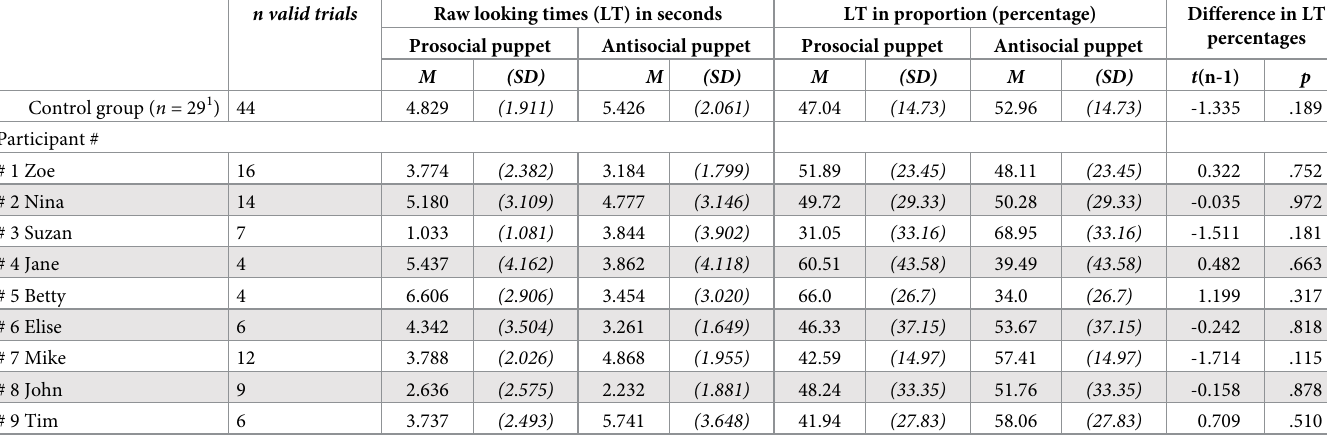
Table 10. Mean (and SD ) looking times (raw and percentage) at each of the two stimuli of the SME-Task’s final preference scene (i.e., prosocial—Or helper—Puppet vs. antisocial—Or hinderer—Puppet), consisting of two 15-second trials, of the control group and the nine PIMD participants. n valid